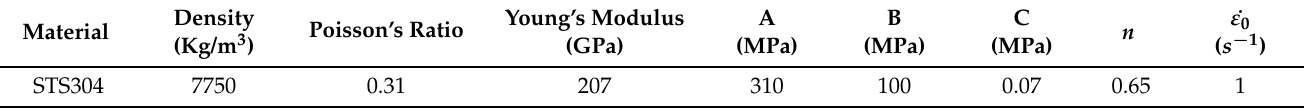
Table 2. Material constants of STS304 and coefficients for JC